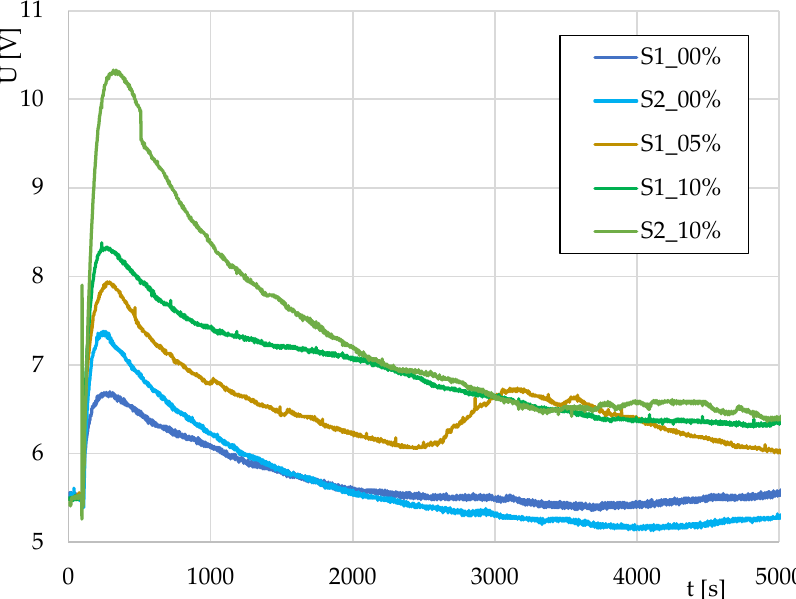
Figure 4. Monitoring of pizza dough leavening without (S1_00%; S2_00%) and with the addition of 5% (S1_05%) or 10% (S1_10%; S2_10%) flour from Tenebrio molitor .